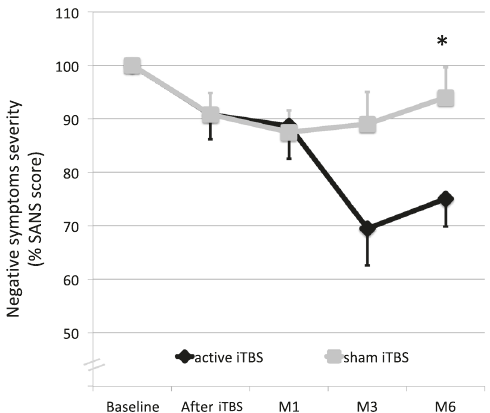
Fig. 1 Clinical effects of iTBS on negative symptoms. Changes in negative symptoms (SANS scores) over time in the active and sham groups receiving intermittent theta burst stimulation (iTBS). M1, M3, M6 represent follow-up assessments at 1, 3, and 6 months after the end of iTBS treatment, respectively. Error bars represent standard errors of the